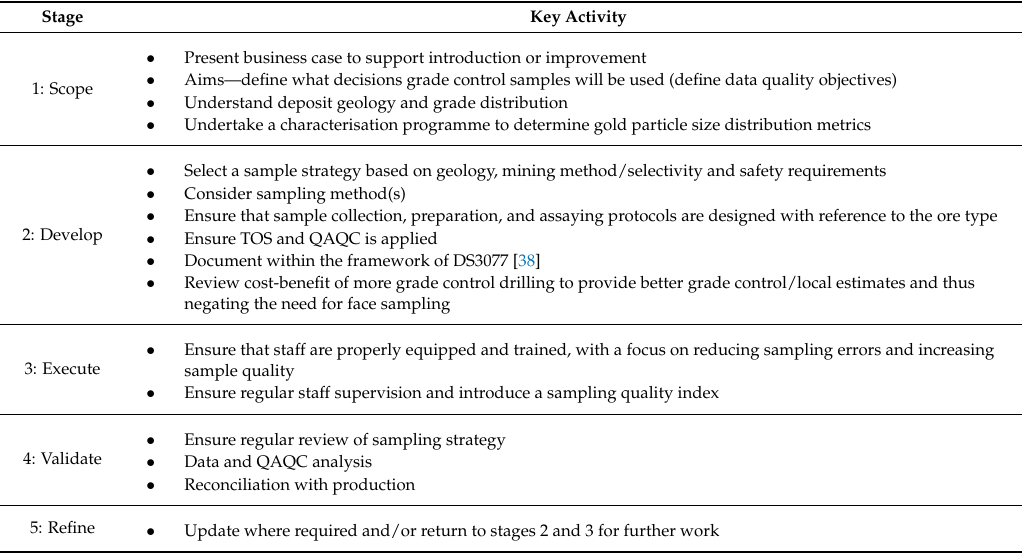
Table 27. Summary of steps to achieve optimal grade control sampling